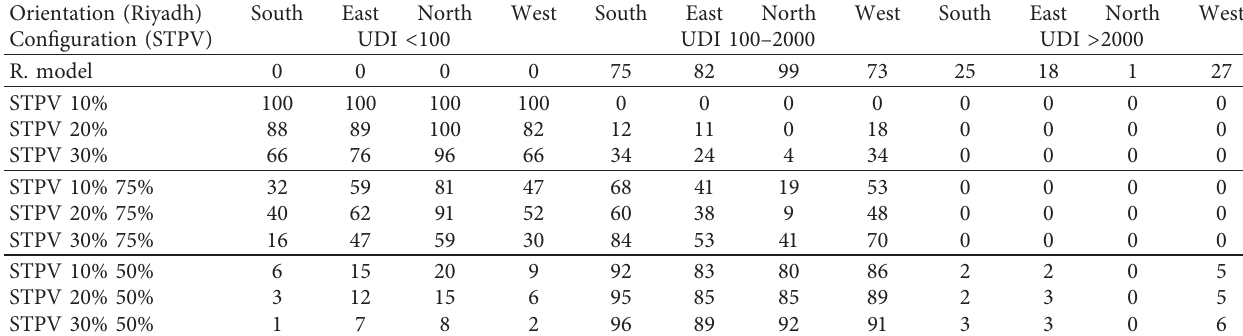
Table 13: UDI thresholds in cardinal orientations under clear sky condition (Riyadh city).